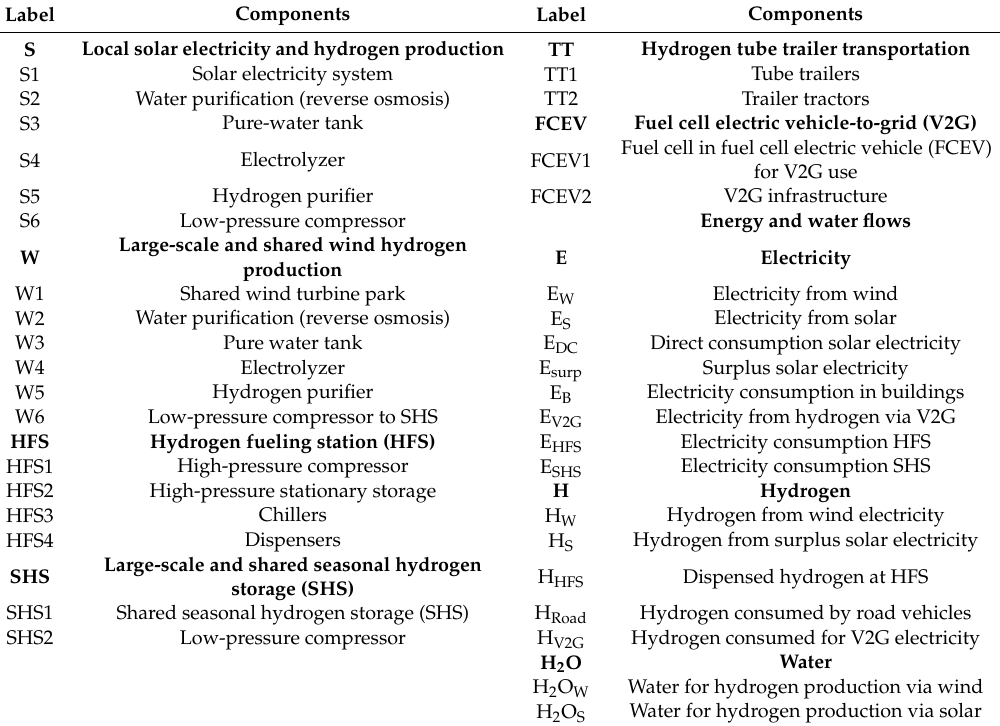
Figure 2. Smart city area components, electricity, water, hydrogen flows, and transportation. fuel cell electric vehicles (FCEV), fuel cell electric vehicle; V2G, vehicle-to-grid. Table 1. Components, energy, and water flow in the smart city area (Figure 2).